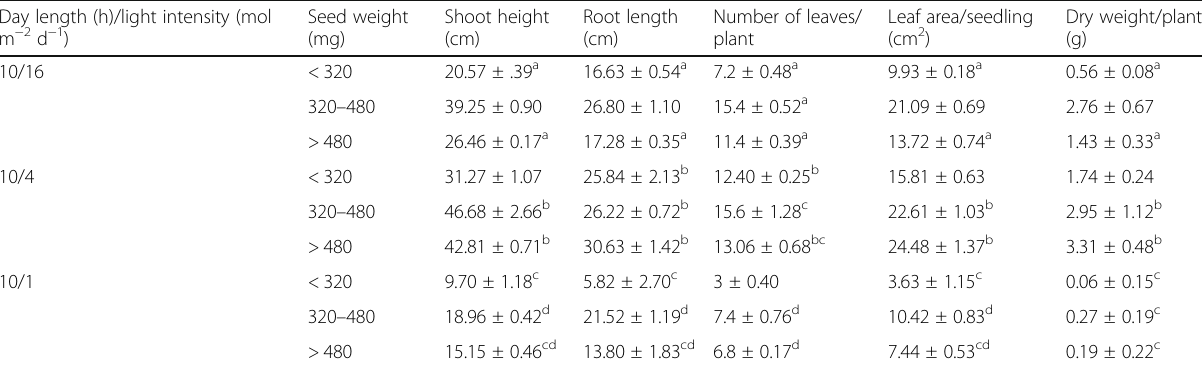
Table 4 Shoot height and root length (cm), number of leaves/plant, leaf area (cm 2 ) and dry weight/plant (g) of seedlings of E. prunifolius (±SEM, n = 10) in light-, intermediate-and heavy-seed weight classes grown under three different contrasting light regimes after 1 year of